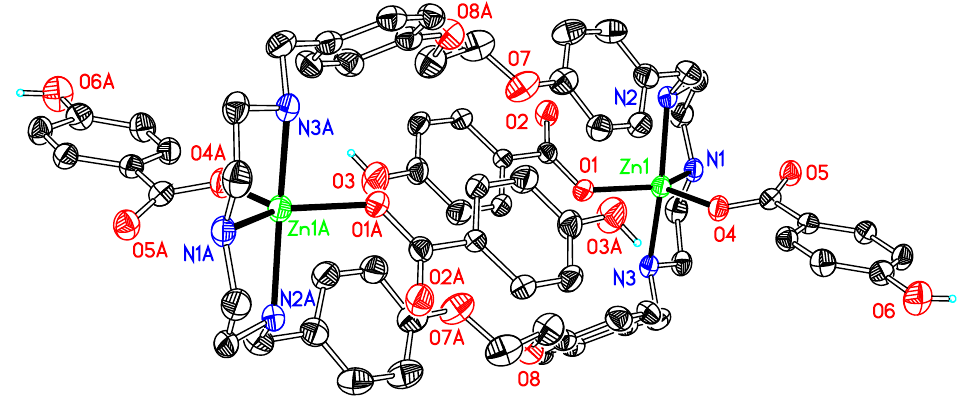
Figure 7. Thermal ellipsoid plot, drawn at the 30% probability level, of [Zn 2 ( p -OCOPhOH) 4 L 1 ] ( 7 ) with atomic numbering scheme. All H atoms, along with the solvents are omitted for clarity. Symmetry codes: A − x, − y, − z. Selected bond lengths (Å) and angles ( ◦ ): Zn1–N1 2.096(3), Zn1–N2